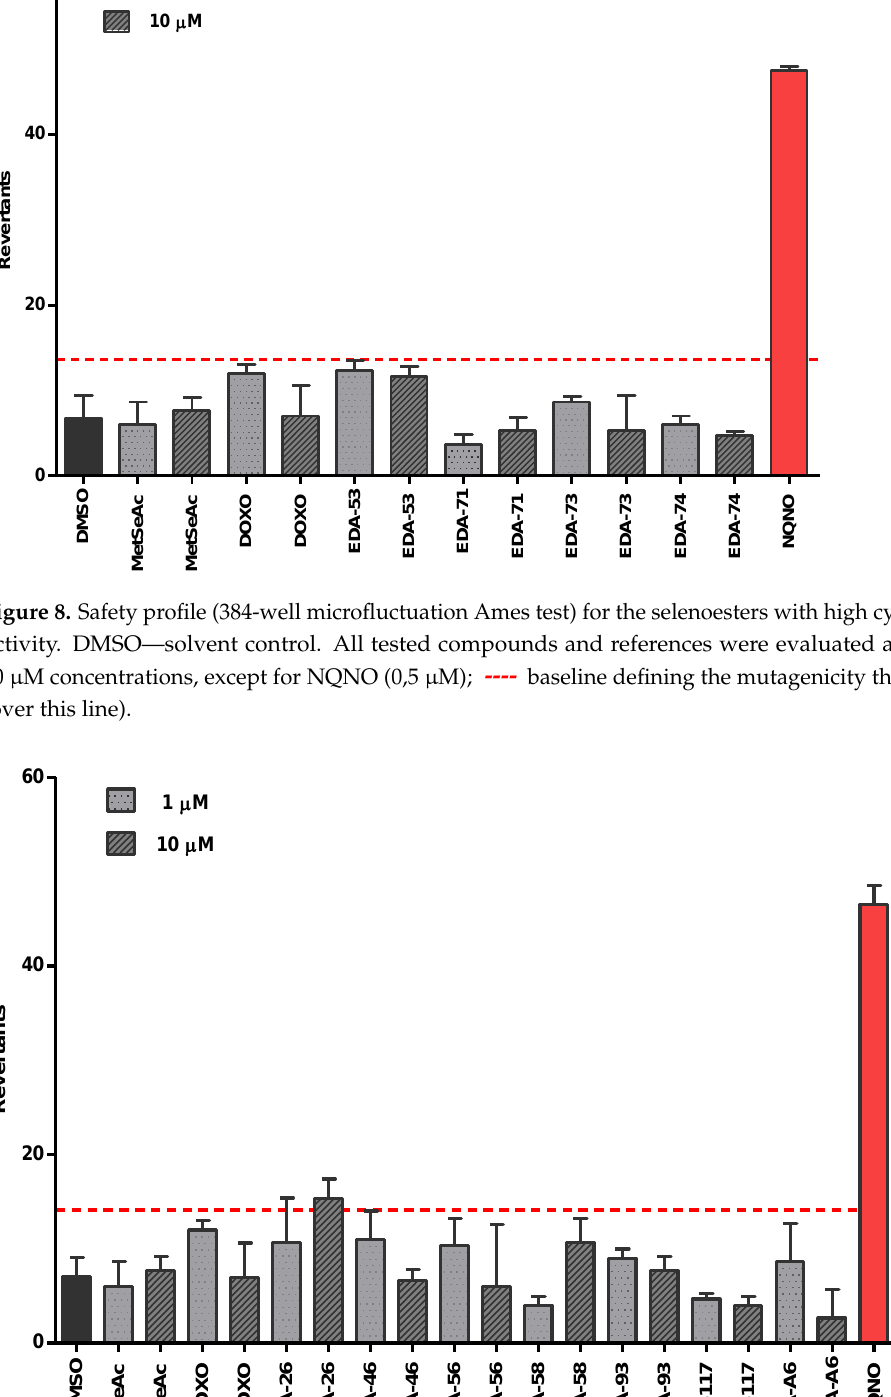
Table 3. Mutagenic index (MI) and other values for methylseleninic acid (reference Se compound), doxorubicin (reference chemotherapeutic), and tested compounds with high cytostatic activity.